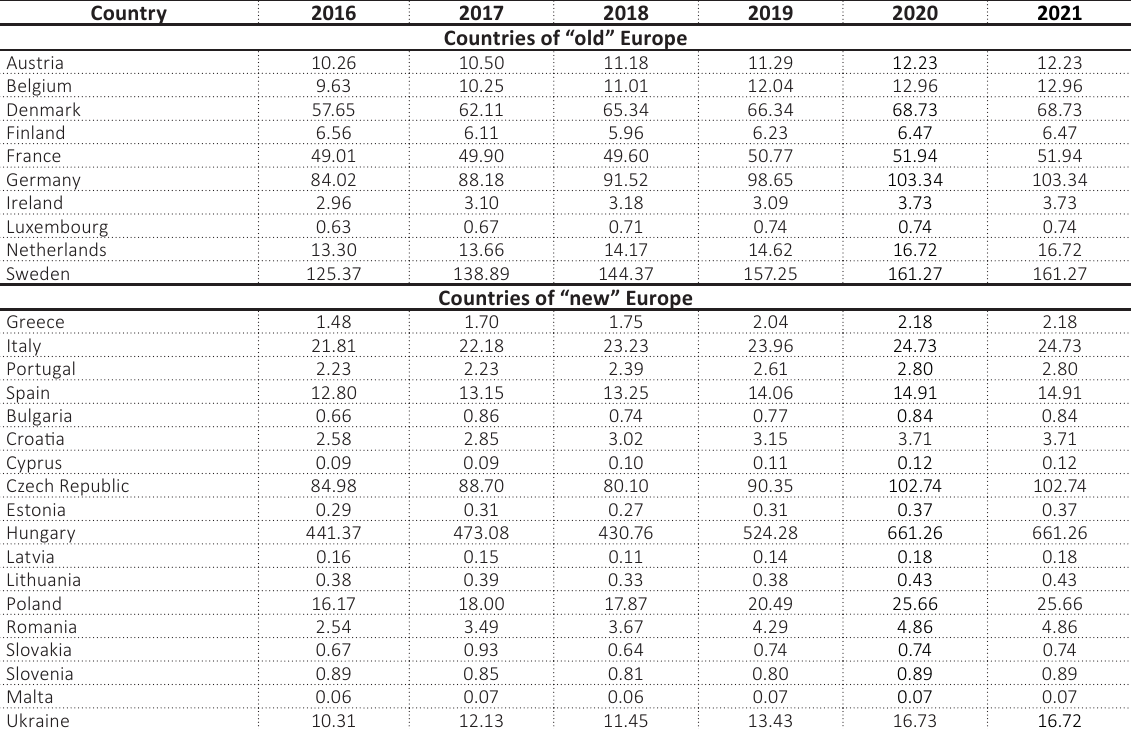
Table B1. Expenditures on research and development, billion US dollars (Х2)